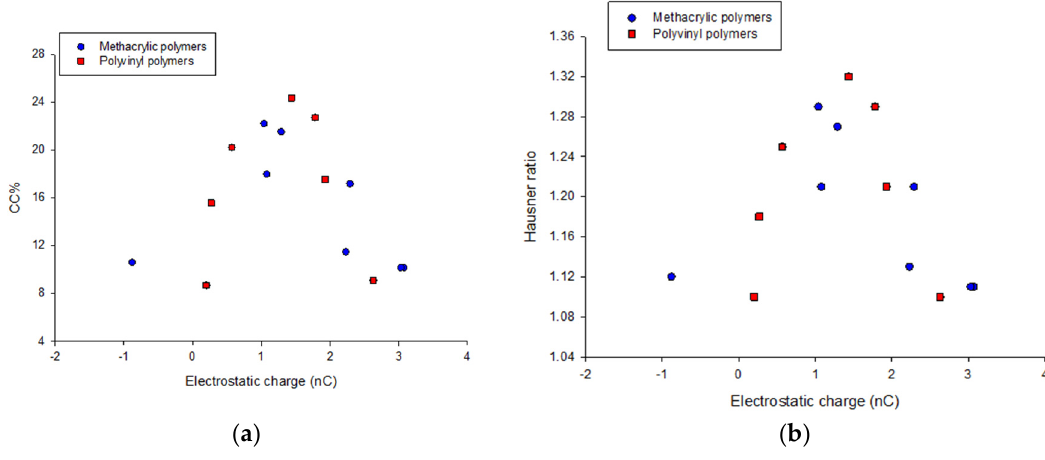
Figure 4. Plots of Carr’s index ( a ) and Hausner ratio ( b ) against an electrostatic surface charge for neat/extruded methacrylic (circles) and polyvinyl based polymers (squares).